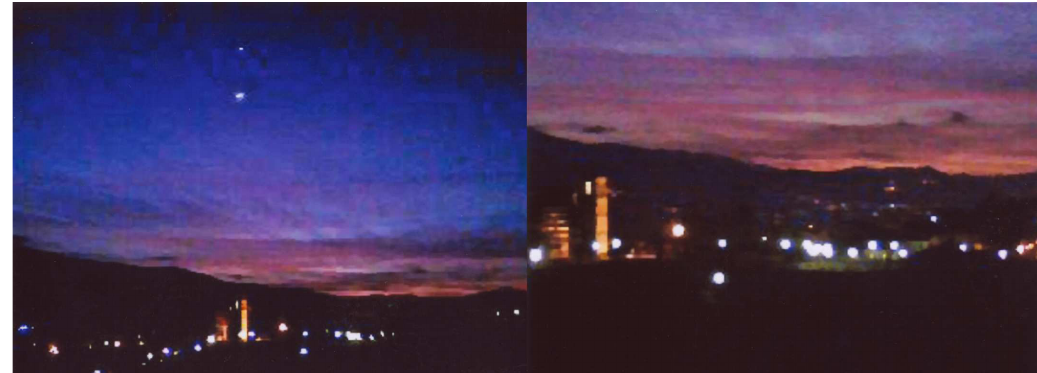
Fig. 1. Reddish diffused light photos from Poggio Picenze towards Aquila (WNW) at about 22:30LT on 5 April 2009. Courtesy of Lucia Miconi. from Pettino toward the Velino-Sirente mountain range, the light shone from the profile of the mountains and was nu- anced. The phenomenon lasted until daybreak, the light was similar to that of the lights at local motorway junction, that is, the colour orange. Streamers were reported in some testimonials immediately after the April 6 main shock in Pettino, Madonna della Strada and Paganica. A few cases described a dark reddish or yellow light high in the sky like an aurora. Yellow- and rose-coloured luminous vapors were observed immediately before and after the main shock by 8 witnesses from: San Demetrio, Poggio Picenze, Barisciano, San Gi- acomo, Cansatessa and San Sisto. Mr. Giuseppe reported seeing it from Cansatessa at about 23:30LT on April 5, right after the first strong foreshock, M=4.2, the sky was blanketed with small disjointed clouds having a light violet shade. The light was brighter above the mountains. At the same time, there was a light-coloured violet fog which reached the crest of the mountains. The fog appeared stratified and very lim- ited in luminosity along the flanks between the Mt. Ocre and Mt. Orsello or more to the north. The vapor was generally re- ported to be low-lying, just a few meters above the ground or covering half of the profile of the mountains along the Aterno Valley. Luminous clouds with orange, red, pink and purple stained outlines were observed. Mr. Alberto Nuvolone from Colle shock, and he recalled that all of the sky was red and black or- ange until about midnight on April 5. He also stated that red- coloured clouds covered the entire sky. The clouds were also lit far from the position of the Moon. This description was compatible with the photos taken in Poggio Picenze, see Fig- ure 1. The same manifestation was reported from the histori-